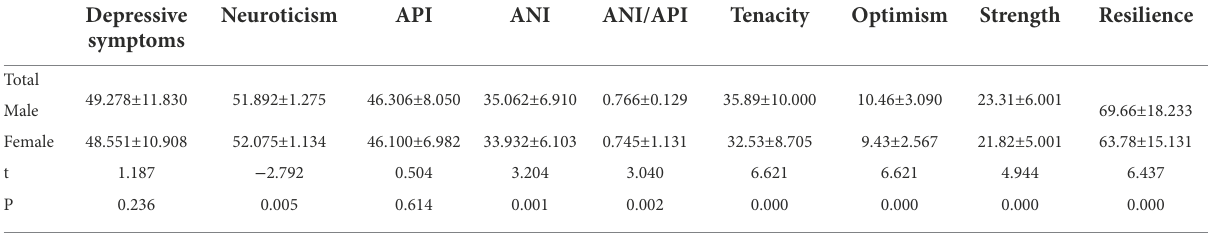
TABLE 3 Comparison of depressive symptoms, neuroticism, attentional bias and resilience scores in men and women (Mean ±